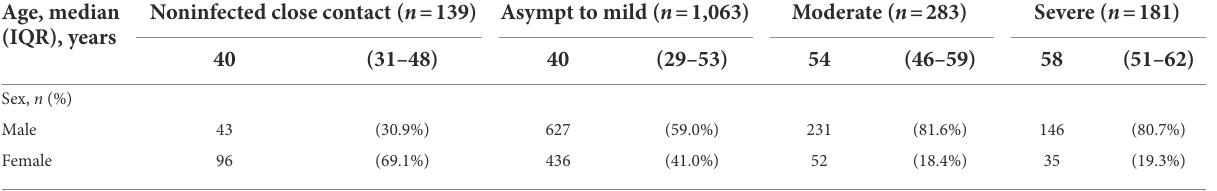
TABLE 1 Characteristics of noninfected close-contact participants in this study and of infected groups enrolled in the Japan COVID-19 Task Force classified by severity of COVID-19. Age, median Noninfected close contact ( n = 139) Asympt to mild ( n = (IQR), years